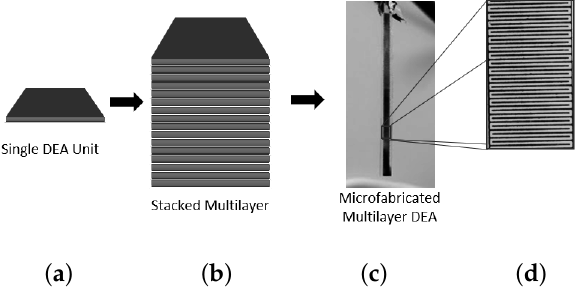
Figure 5. ( a ) Schematic of a single DEA structure with the dielectric membrane sandwiched between two parallel conductive layers; ( b ) schematic of a stacked DEA structure with many layers of alternating dielectric and conductive elastomers; ( c ) actual stacked DEA fabricated using a microfabrication approach; ( d ) microscope image of the interdigitated conductive elastomer layers in the photoresist